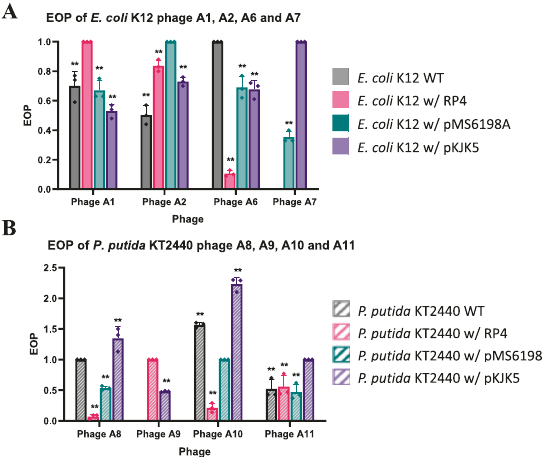
Fig. 2 EOP of phages conducted against its original bacteria host and other permissive bacteria host. A EOP of E. coli K12 phages ( B ) EOP of P. putida KT2440